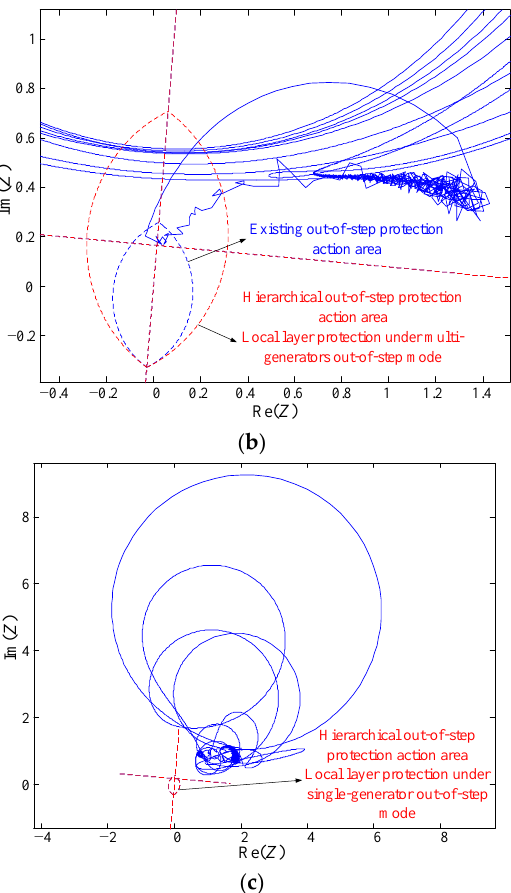
Figure 13. Measured impedance trajectory and the local layer protection action characteristics: ( a ) measured impedance trajectory of G1 and the local layer out-of-step protection action characteristics, ( b ) measured impedance trajectory of G2 and the local layer out-of-step protection action characteristics and ( c ) measured impedance trajectory of G3 and the local layer out-of-step protection action characteristics.